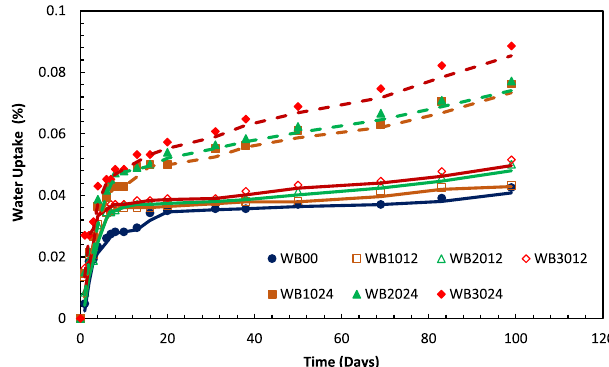
Figure 5. Water absorption of PP and GFRPP with different fiber lengths.